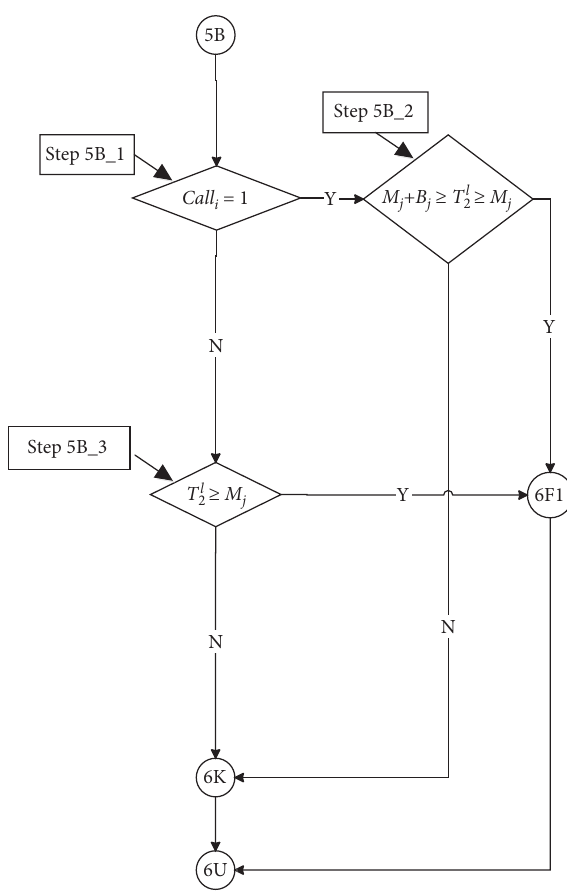
Figure 3: Steps of the TPS_DT algorithm Part 5B shown in Figure